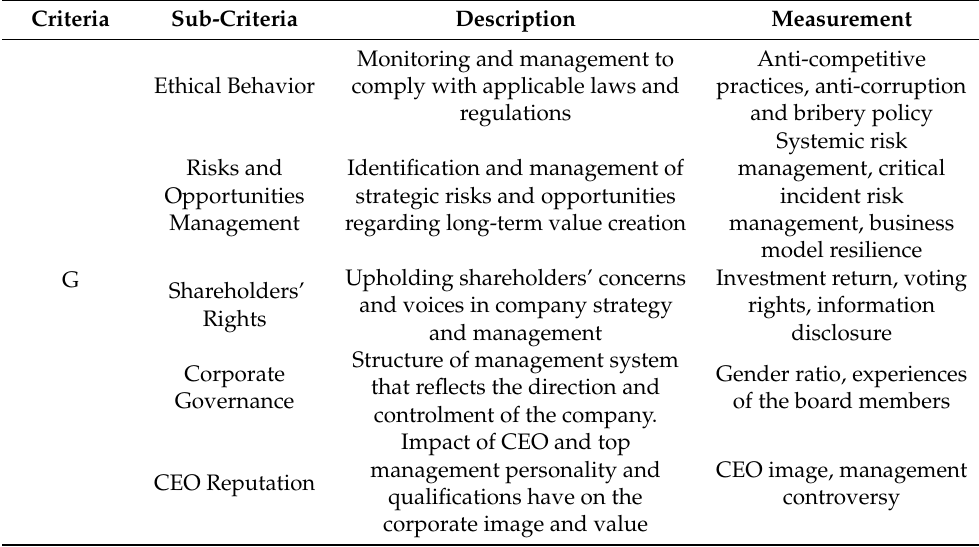
Table A9. Sub-criteria (governnance factors): definitions and descriptions of key components.